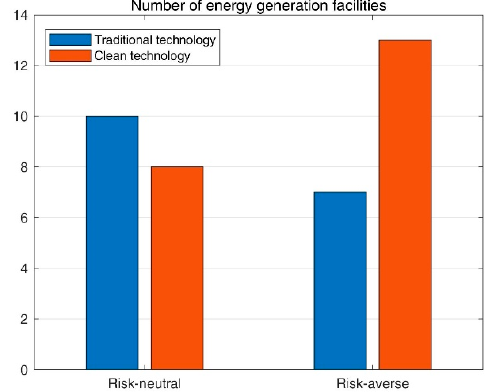
Figure 5. Number of energy generation facilities built resulting from the risk-averse and risk-neutral model.